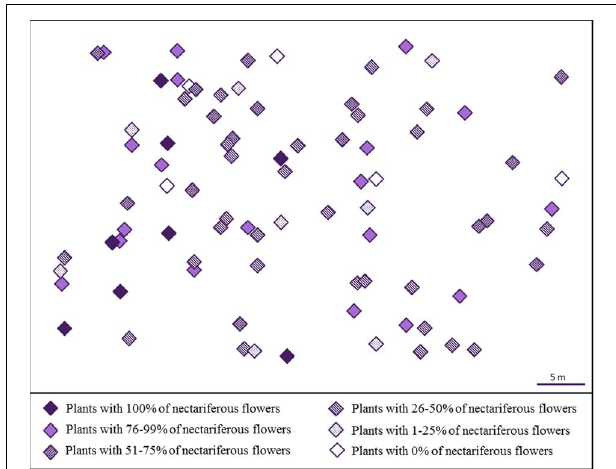
FIGURE 2 | Spatial distribution of J . oxyphylla (Bignoniaceae), Botucatu, Brazil. Each diamond represents a single plant. The colors and patterns inside the diamonds indicate the percentage of nectariferous flowers found in each